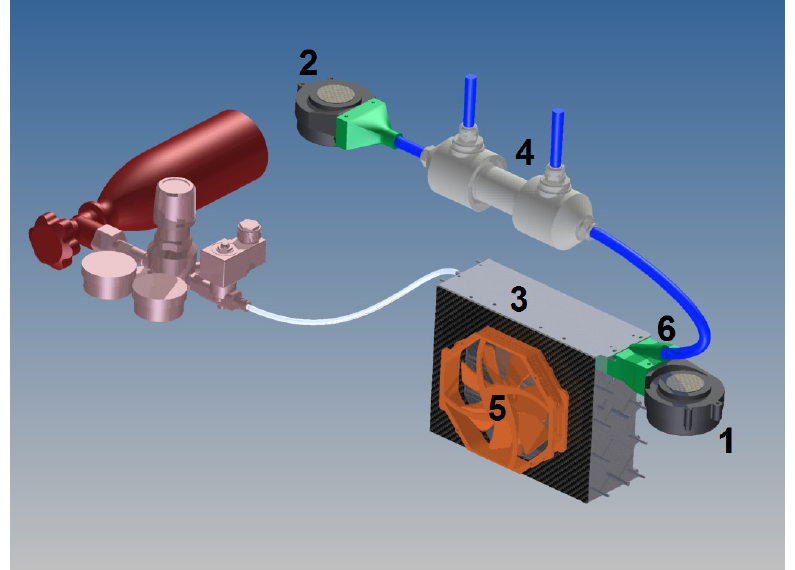
Figure 4. Scheme of the fuel cell circuit with the